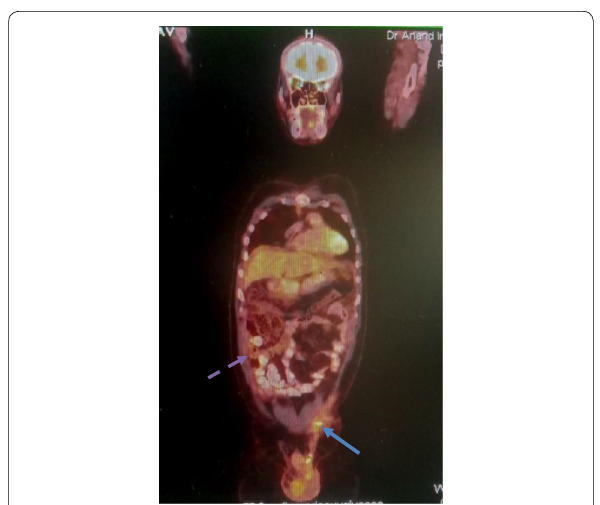
Fig. 3 PET/CT image depicting left inguinal (blue arrow) and peritoneal (dotted arrow)